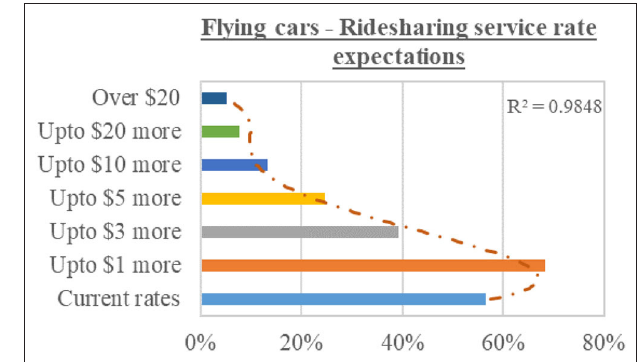
FIGURE 9 | Willingness to